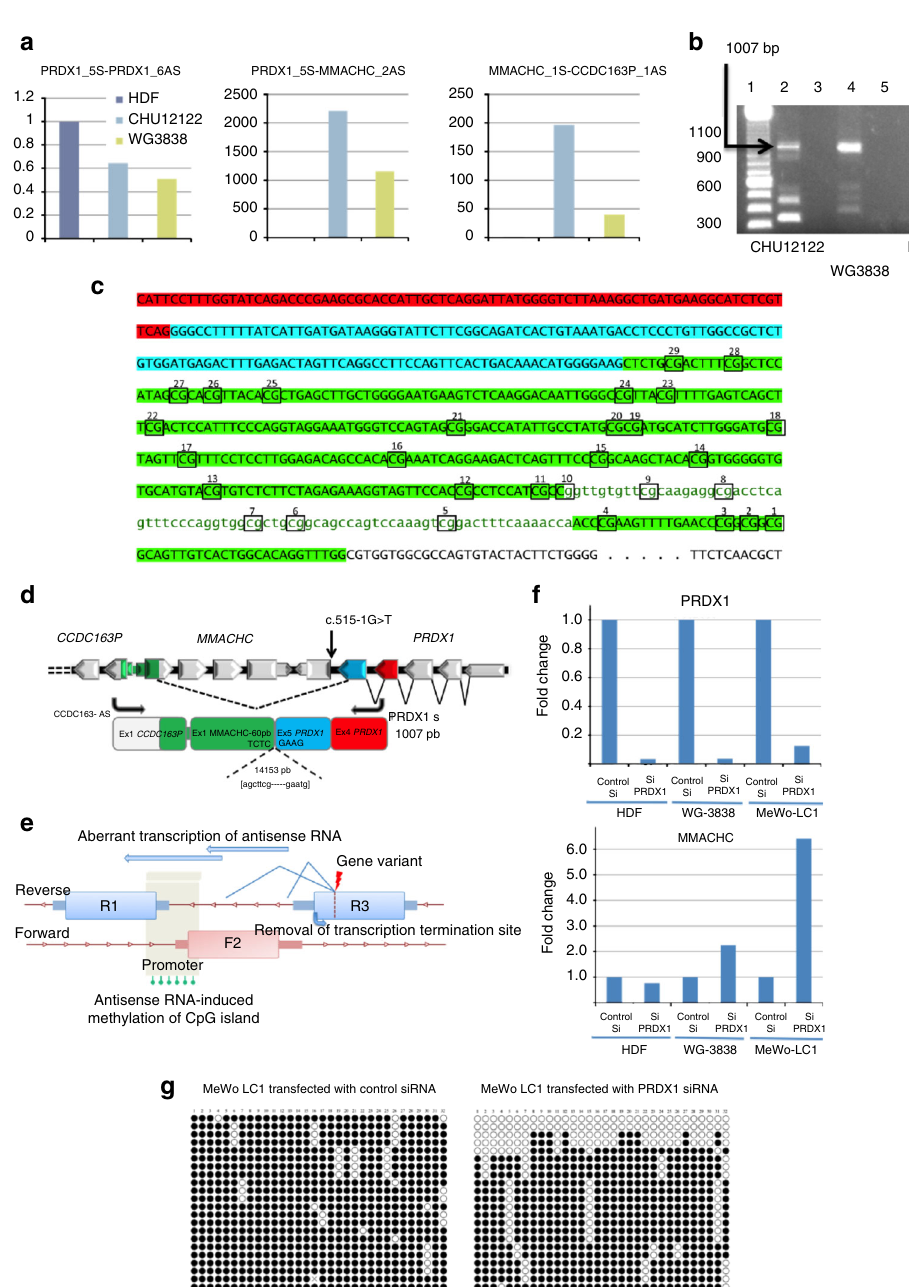
Fig. 6 The PRDX1 mutation causes aberrant antisense transcription through the MMACHC and CCDC163P genes. a qRT-PCR analyses of antisense transcripts encompassing exons 5 and 6 of PRDX1 , PRDX1 exon 5 — MMACHC exon 1 and MMACHC exon 1- CCDC163P exon 1 showing the aberrant extension of PRDX1 antisense transcription through sense MMACHC and antisense CCDC163P and no aberrant transcripts in HDF control fi broblasts. b RT-PCR detection of an aberrant 1 kb transcript produced with PRDX1 sense and CCDC163P antisense primers. Lanes 2, 4, and 6 correspond to RT-PCR of RNA from fi broblasts CHU-12122, WG-3838, and HDF (control fi broblasts). Lanes 3 and 5 correspond to control experiments without fi broblast RNA in the reaction mixture. They show no ampli fi cation artifacts. c, d Sanger sequencing of cDNA shows that the antisense aberrant transcript encompasses PRDX1 exons 4 (red) and 5 (blue), part of exon 1 and promoter of MMACHC , and part of exon 1 of CCDC163P (green). e Proposed mechanisms of epigenetic silencing of the non-mutated F2 allele in patients with a heterozygous mutation of a causal gene that belong to a trio of reverse (R1) – forward (F2) – reverse (R3) genes. f Expression of PRDX1 and MMACHC in control fi broblasts, fi broblasts of patient WG3838 , and MeWo-L1 cell line transfected with control and PRDX1 siRNA. g MMACHC methylation epigrams of MeWo-LC1 cells transfected with control and PRDX1 head sense – antisense gene pair (SAGP) constituted by of exon 1 of MMACHC and the promoter, and restored the CCDC163P and MMACHC . The forced antisense transcription of transcription of MMACHC , in WG-3838 and MeWo-LC1 cells. MMACHC resulted from the skipping of the last exon of PRDX1 . However, the silencing of PRDX1 produced only 10 – 15% hypo- This skipping was the causative defect that produced the epi- methylation of the allele initially fully methylated, suggesting a mutation since the silencing of PRDX1 decreased the methylation limited reversibility of the epimutation (Fig. 6g). Antisense